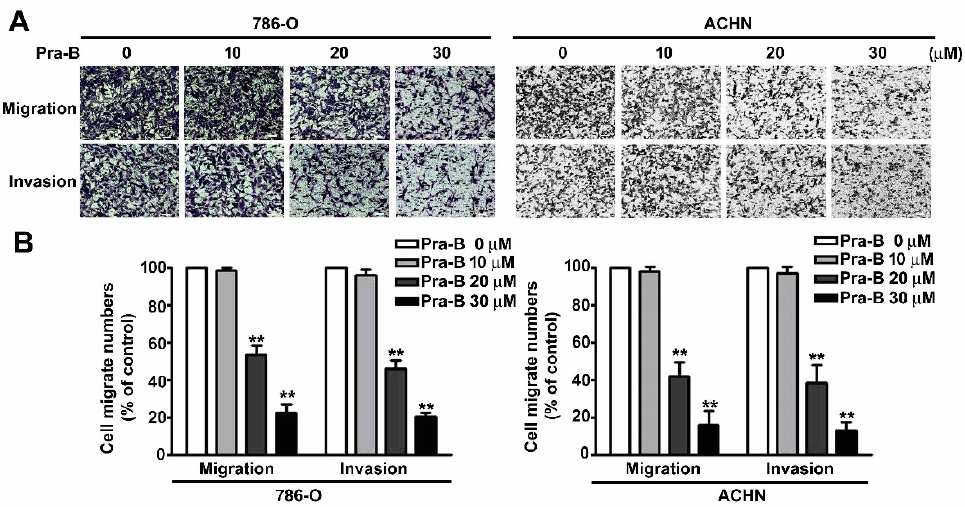
Figure 2. Inhibitory e ff ects of Pra-B on cell migration and invasion of 786-0 and ACHN cell. ( A ) Cells were treated with various concentrations of Pra-B (0, 10, 20, and 30 µ M) for 24 h followed by the analysis of 786-0 and ACHN cell migration and invasion by using an in vitro migration and Matrigel-based invasion assay. ( B ) Quantification of migrating cells presented in terms of percentage of control (0 µ M) is shown as a histogram, as determined in at least three independent experiments. ** p < 0.01 relative to the control. Scale bar = 50 µ m.